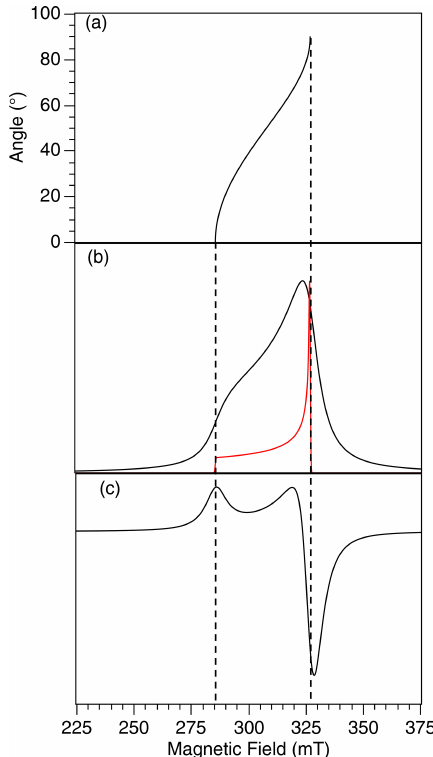
Figure 2. (a) Angular variation of the EPR resonance field accord- ing to Eq. (2) for Cu 2 + in cuprorivaite. (b) Spectral density in red and the corresponding EPR absorption spectrum in black consider- ing a non-zero line width. (c) Actual EPR spectrum corresponding to the absorption